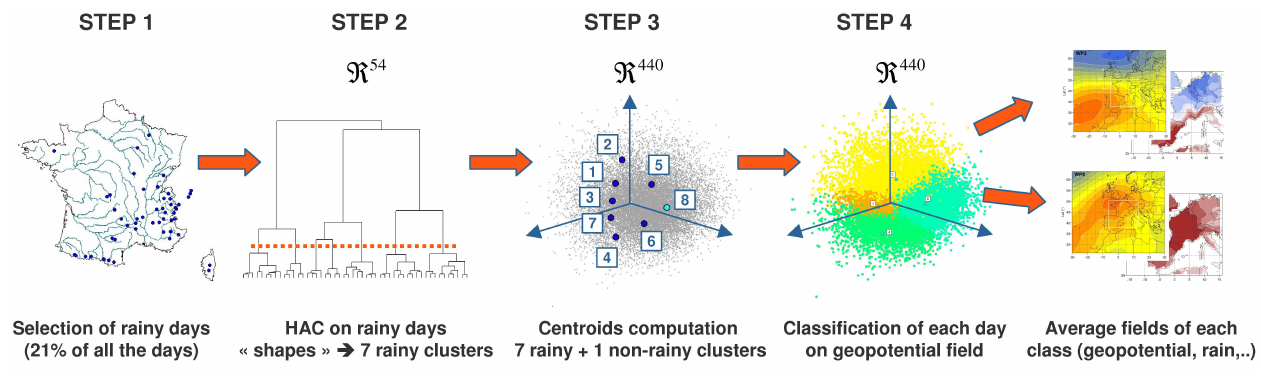
Fig. 2. WP classification